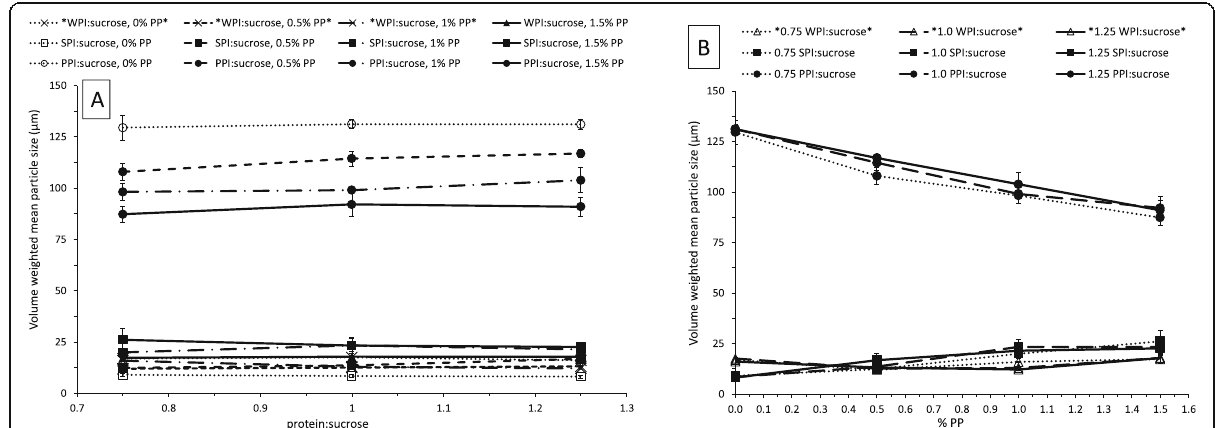
Fig. 4 Effect of protein:sucrose ratio ( A ) and PP content (%) ( B ) on the average particle size ( μ m) of dispersions at 25 °C; (averaged data plotted, n = 9). Legend entries marked * contain data points reported in previous work (Hansen et al., 2021a; averaged data plotted, n = 6). Lines are for